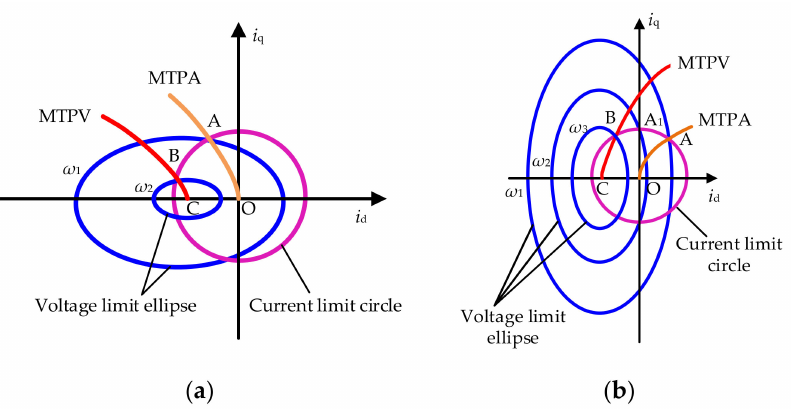
Figure 3. The PMSM current vector trajectory for ( a ) conventional IPMSM; ( b )